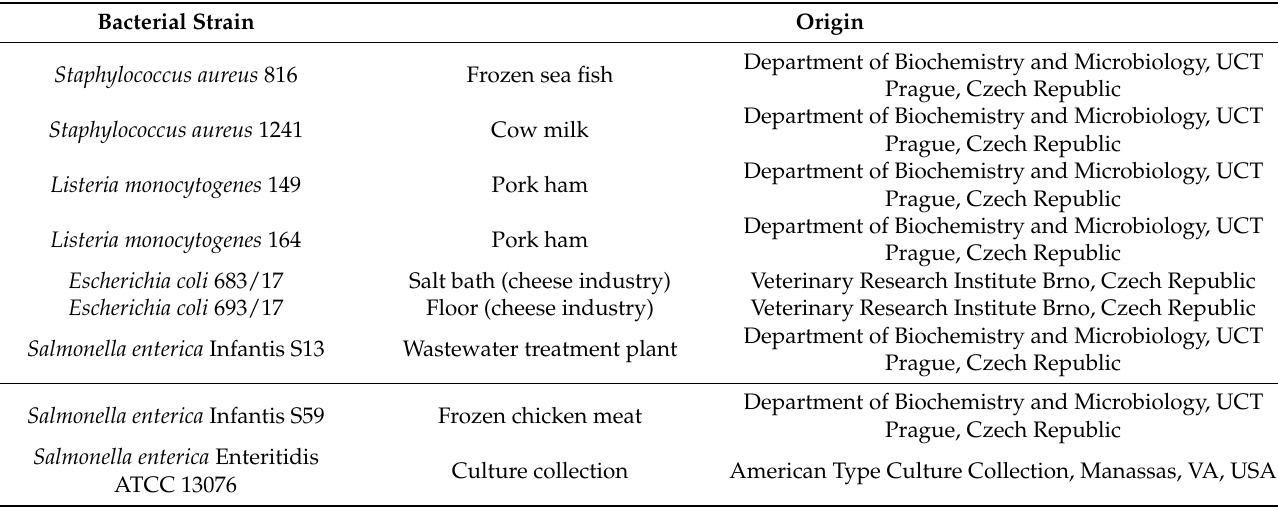
Table 6. List of bacterial strains and their